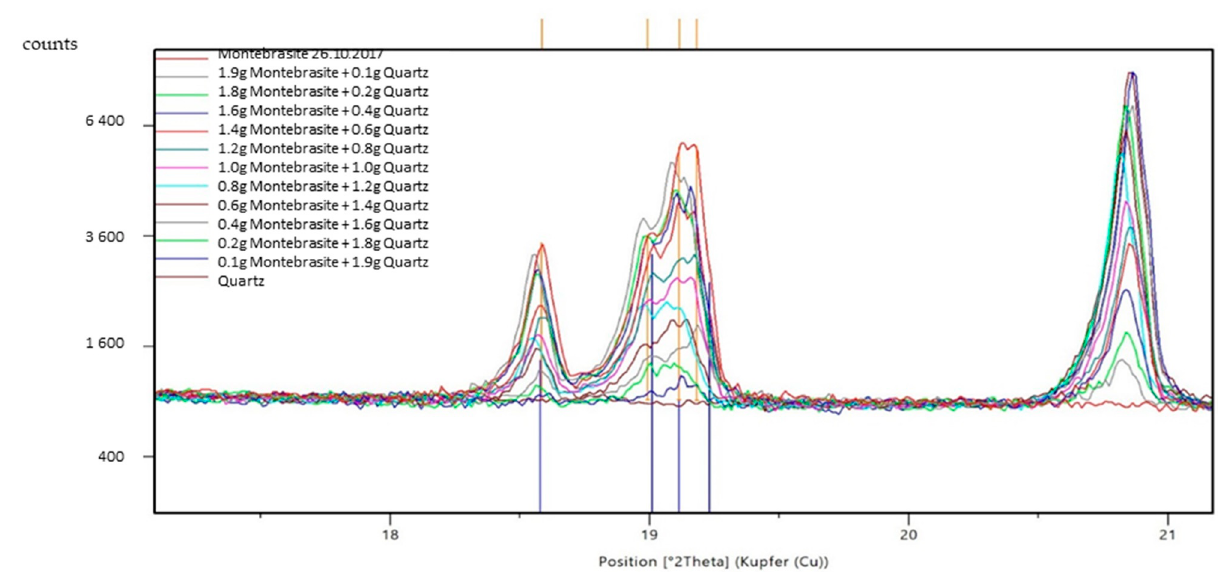
Figure 16. XRD patterns showing different contents of montebrasite–quartz mixtures.